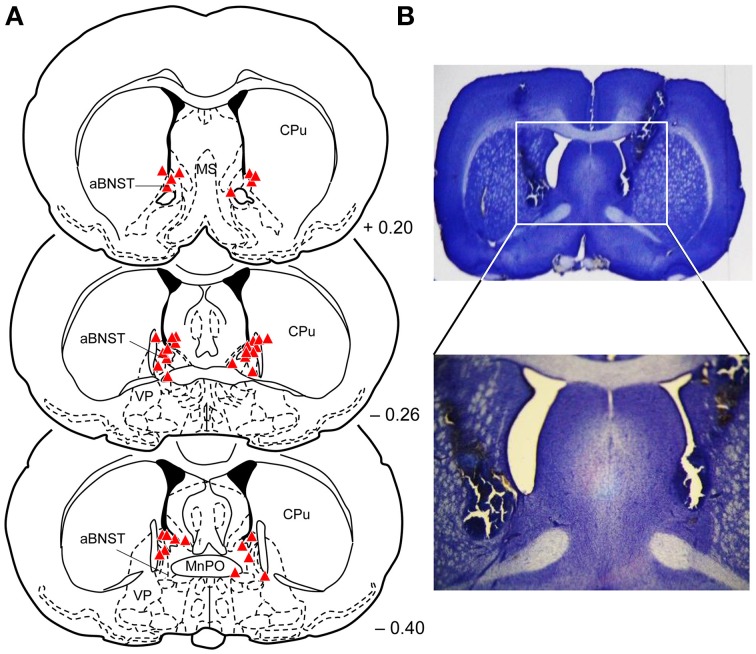
Injection sites into the aBNST. (A) Reconstruction of the different injection sites of saline or muscimol into the aBNST. The coronal sections were taken from the atlas of Paxinos and Watson (2014). Numbers indicate distance from bregma in mm. aBNST, anterior bed nucleus of the stria terminalis; MnPo, median preoptic nucleus; MS, medial septal nucleus; CPu, caudate putamen; LPO, lateral preoptic area; VP, ventral pallidum; f, fornix. (B) Photomicrographs with a representative example of aBNST injection sites.